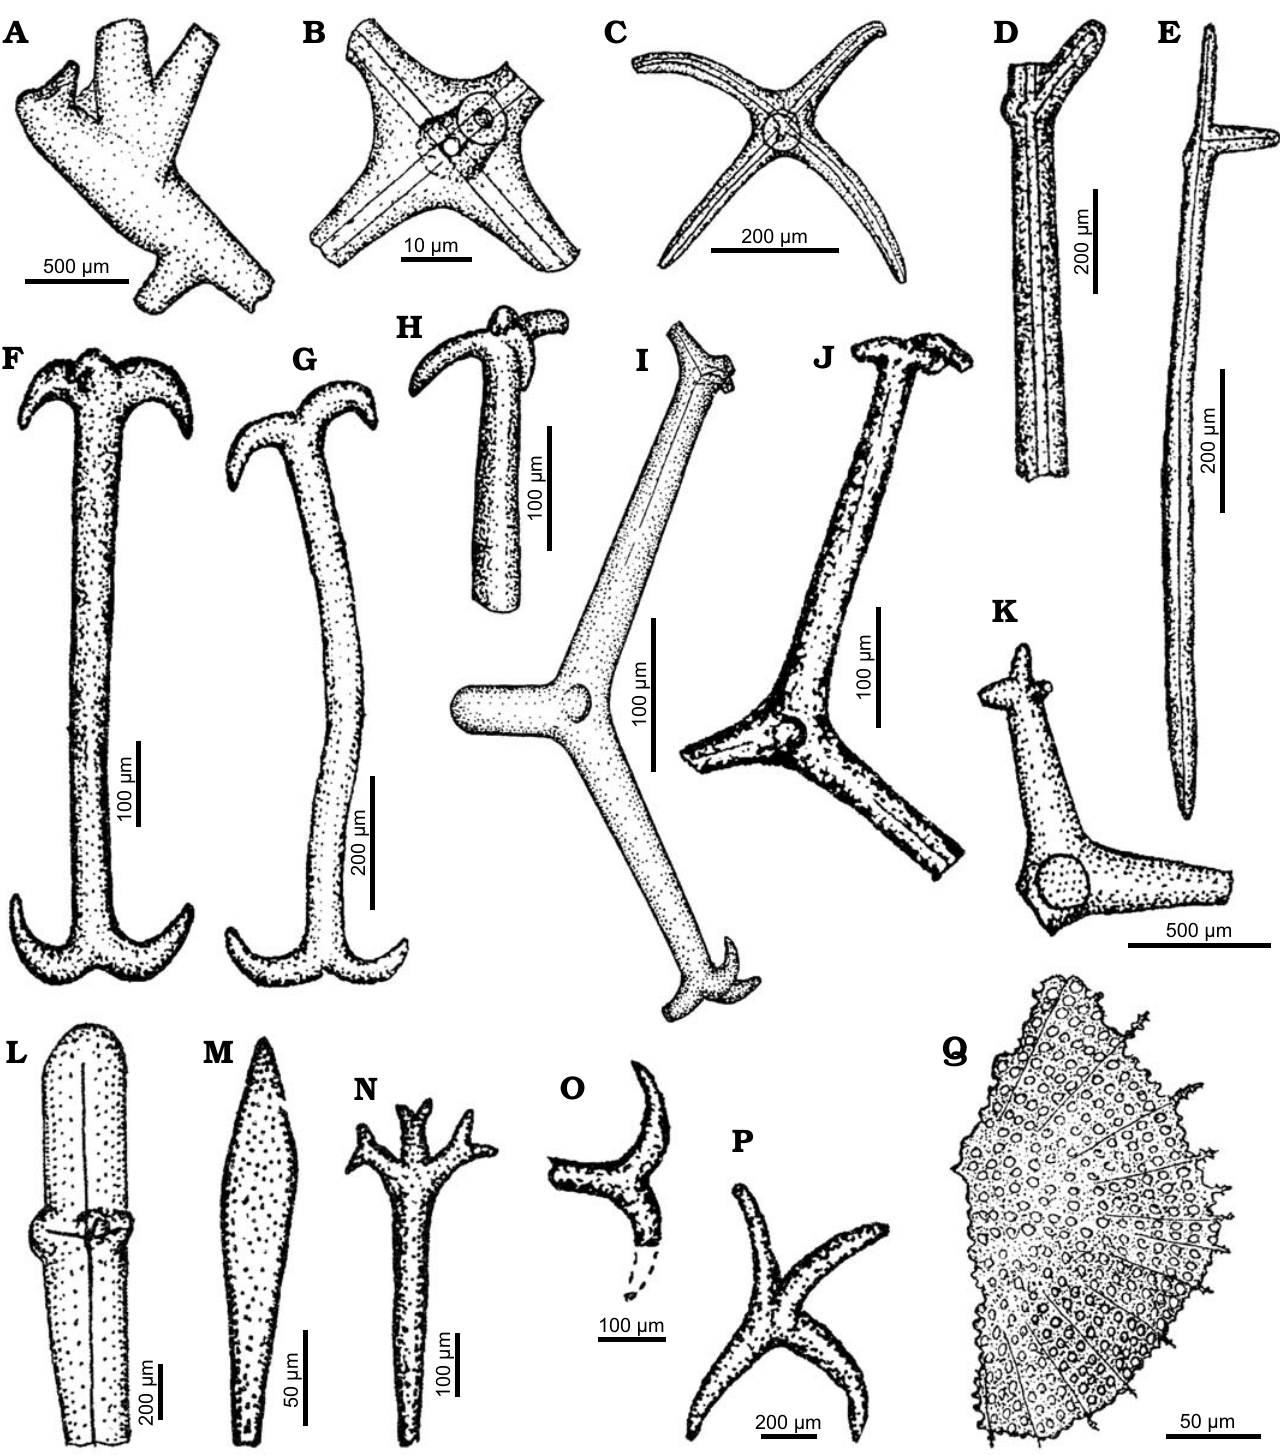
Fig. 8. Spicule morphotypes from south-central Ukraine; Verhnee, lower Eocene (A, K, L, P), Russkie Ti ŝ ki, middle Eocene (B, D, N, Q), Nikol’skoe, upper Eocene (C, E, G, J), Markovka, upper Eocene (F, O), Lipcy, middle Eocene (H), Melovoe, upper Eocene (I), and Kantemirovka, upper Eocene (M). A . ?Fragment of dictional skeleton. B . Pentactine. C . Hexactine. D , E . ?Oxeas. F , G , O . Amphiclads. H . Broken lophodiactine. I , J . Lophocalthrops. K . ?Lophocalthrop. L . Spicule fragment. M . ?Spicule fragment. N . Dichotriaene. P . Calthrop. Q . Fragment of a diatom. After Ivanik (2003);